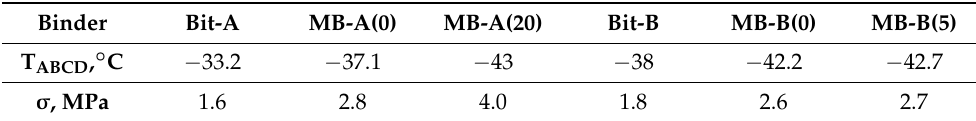
Table 5. ABCD test results.